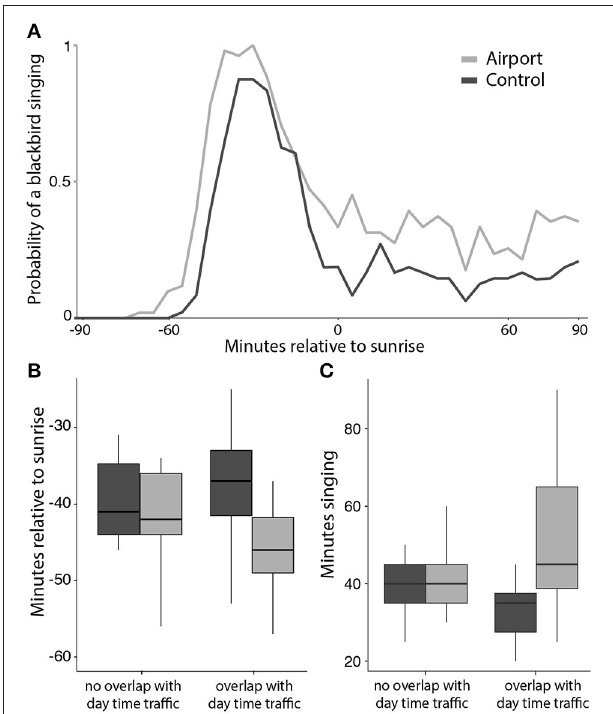
FIGURE 6 | Characterization of the temporal parameters of dawn chorus. Curves in (A) show the probability of hearing a blackbird singing at dawn. All recordings were standardized in relation to sunrise time = 0, negative numbers meaning minutes before sunrise. Boxplots in show the differences in onset of dawn chorus in minutes relative to sunrise (B) and the duration of the chorus (C) , depending on whether the chorus overlapped with day time traffic or not.